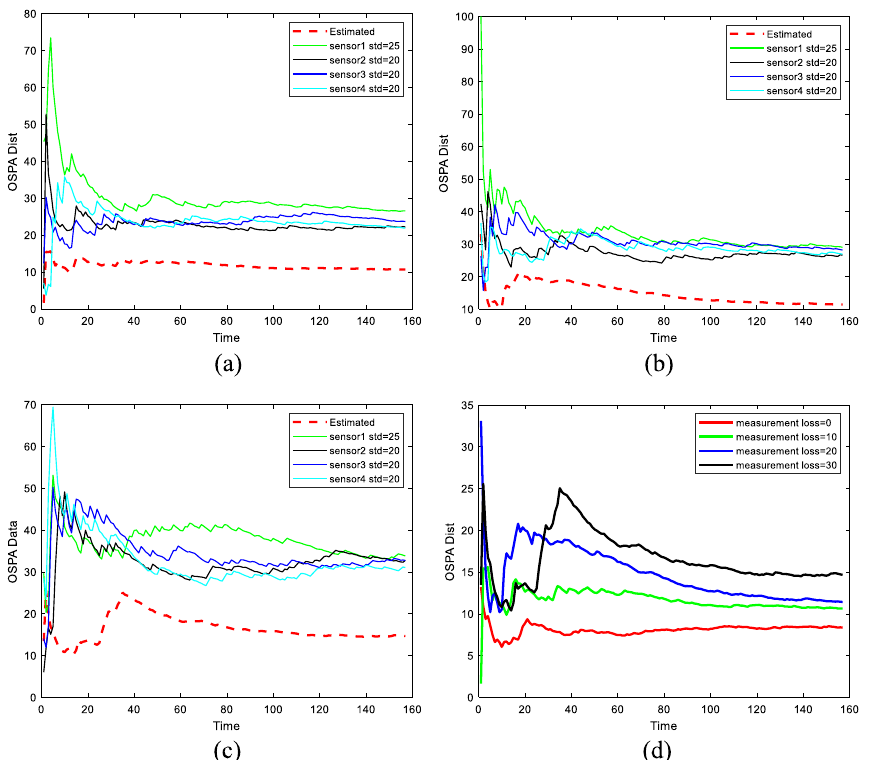
Fig. 12 Effect of missing measurement on estimation